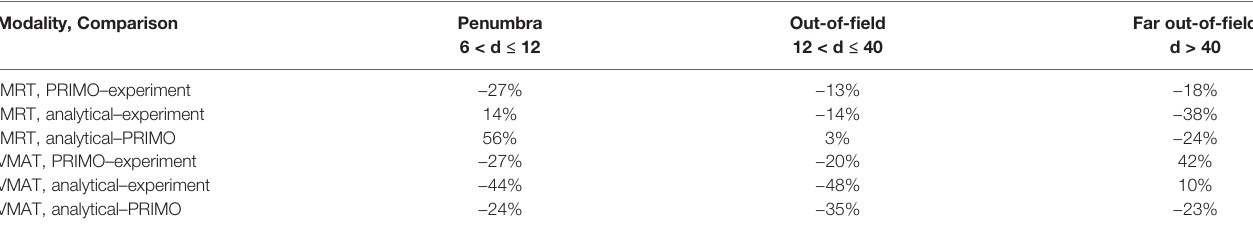
TABLE 4 | Average relative discrepancies between the computed and experimental dose in the three regions de fi ned for both intensity-modulated radiotherapy (IMRT) and volumetric modulated arc therapy (VMAT) irradiations. Modality, Comparison